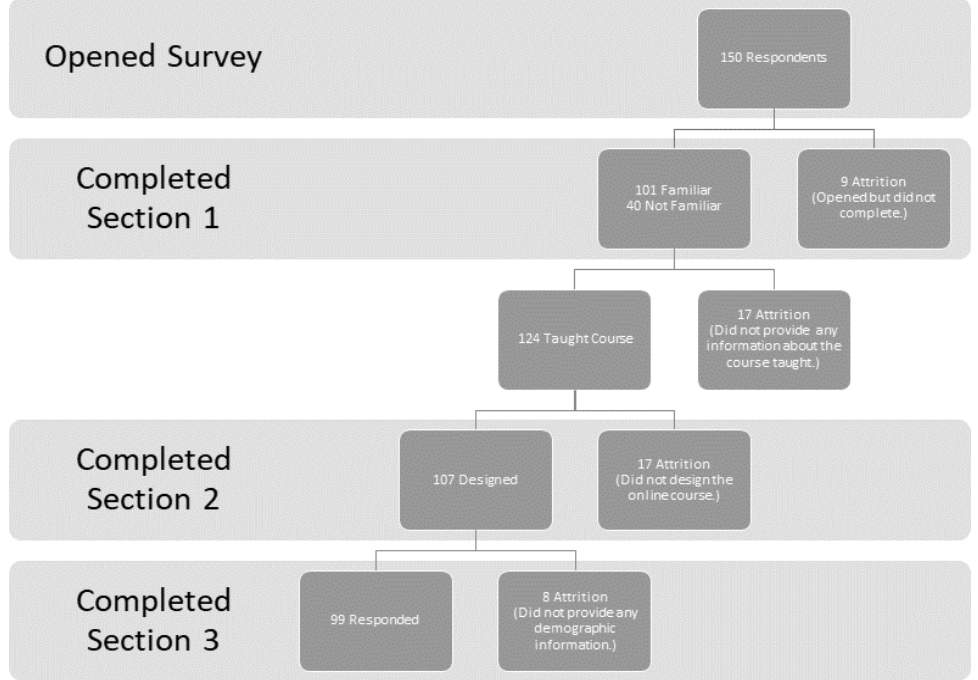
Figure 2. Response rates and attrition points for each of the three survey